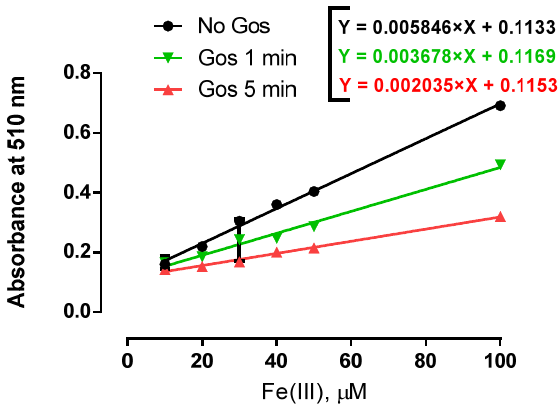
Figure 7. Gos inhibits Fe(III)-reduction by ascorbate in the absence of rat liver mitochondria. Exper- imental conditions: 125 mM sucrose, 65 mM KCl, 10 mM HEPES buffer (pH 7.2), 1 mM citrate, Gos 100 µM. Experiments were conducted at 28 °C. Ascorbate (4 mM) and 5 mM 1,10-phenanthroline were added after 1 min or 5 min of Gos-Fe(III) incubation. Lines are representative of three assays.